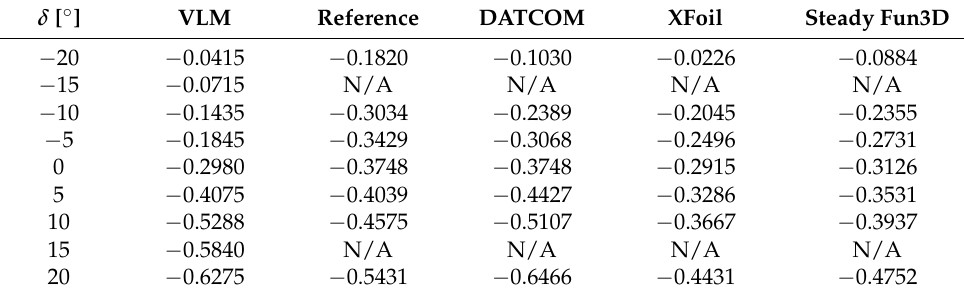
Figure A3. h C versus δ for GA(W)-1 at alpha 16°.